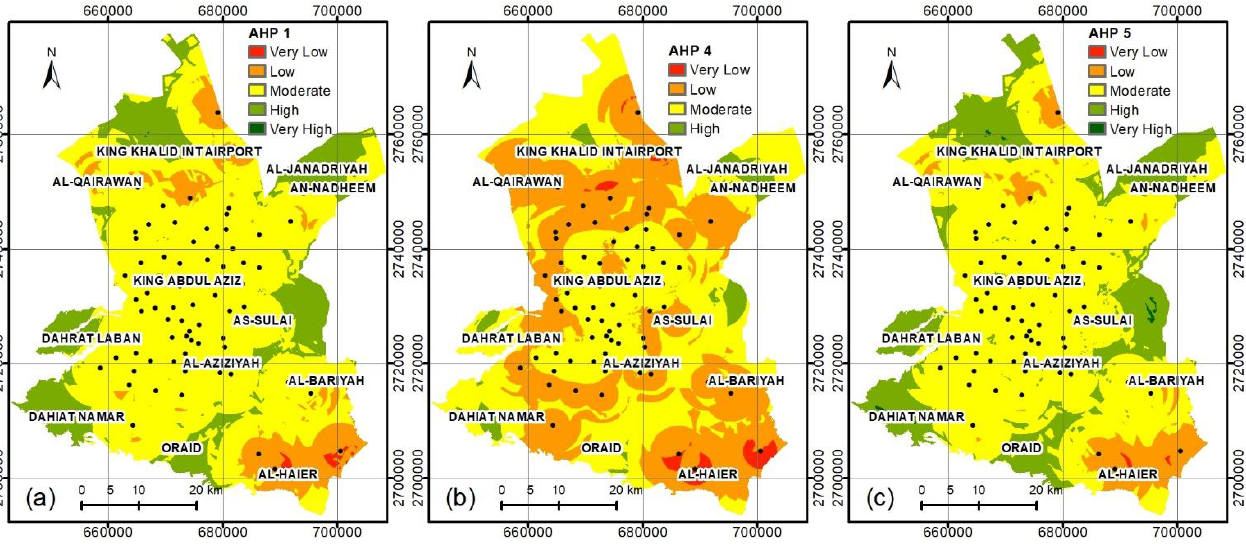
Figure 6. Best spatial distribution of the CDC maps after adding the existing CDC factor to the three models, which are ( a ) AHP-1, ( b ) AHP-4, and ( c ) AHP-5.